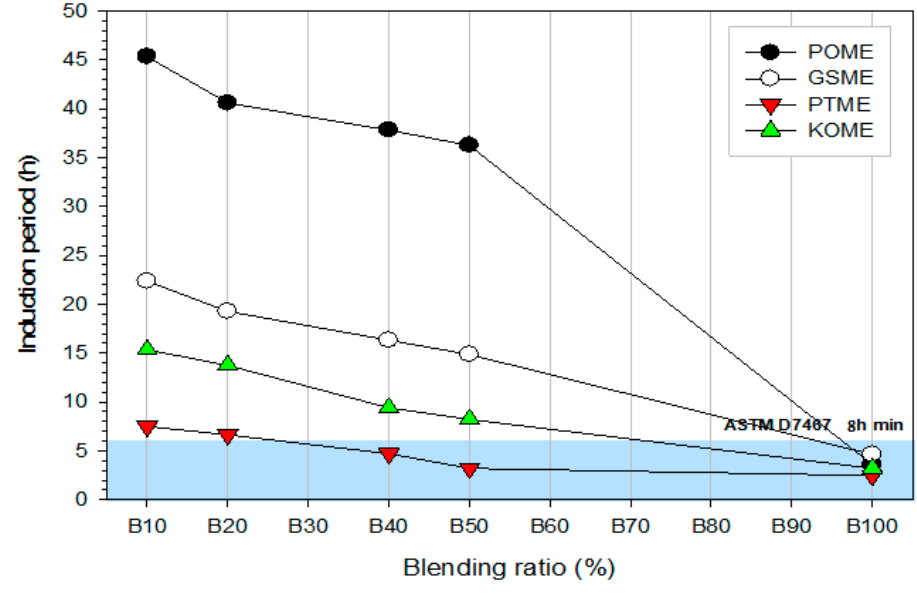
ff ects of biodiesel–diesel blends on oxidation Figure 3. Effects of biodiesel–diesel blends on oxidation stability. Figure 3. E